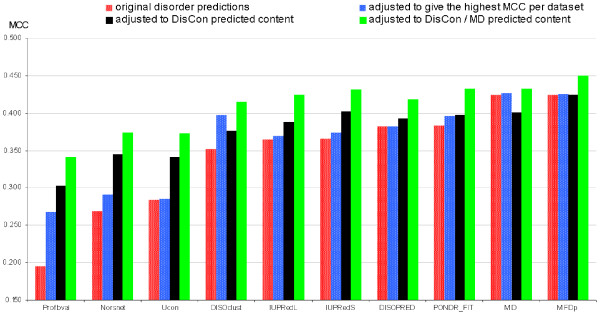
The MCC values for the residue-level disorder prediction adjusted using content predicted by DisCon. The bar chart includes the original predictions (densely dotted red bars), predictions with a fixed cut-off that is optimized to maximize MCC on the entire test dataset (sparsely dotted blue bars), predictions where the content predicted by DisCon is used to adjust the cut-off (solid black bars) and where the content predicted by MD if its values are > 0.65 or < 0.1 and otherwise content predicted by DisCon are used to adjust the cut-off (solid green bars). The results were computed on the test dataset and the methods on the x-axis are sorted by their original MCC values.